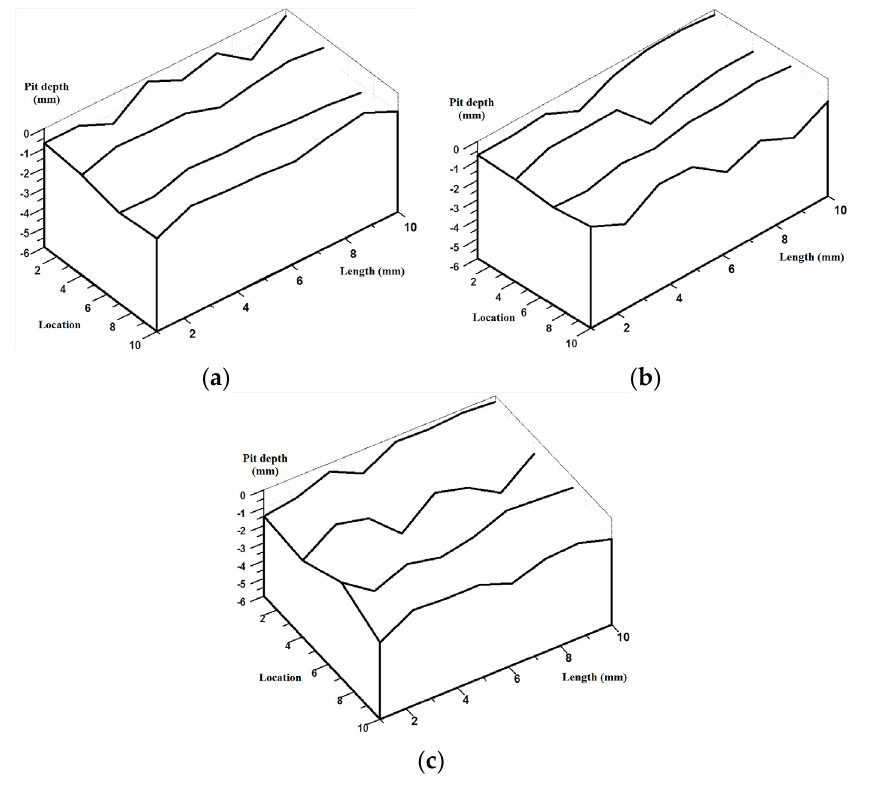
Figure 13. Surface profile curves of finite element models based on Table 8: ( a ) R a ‐ 1; ( b ) R a ‐ 2; ( c ) R a ‐ 3.